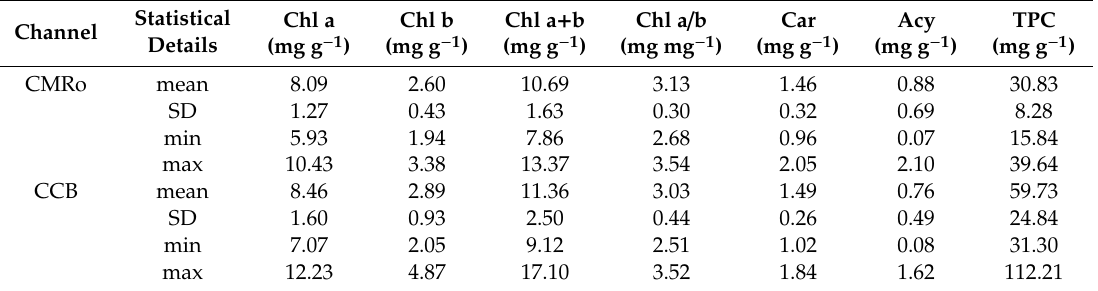
Table 4. Leaf pigment content (chlorophyll a, b, total chlorophyll, ratio a / b; carotenoids (car)), content in anthocyanins (Acy) and total phenolic compounds (TPC) of apical shoots (10 cm) taken from two stands of five sections of two navigation channels in Northeast France, the Canal from Champagne to Bourgogne (CCB) and the Canal from the Marne to the Rhine, Western Branch (CMRo). Channel